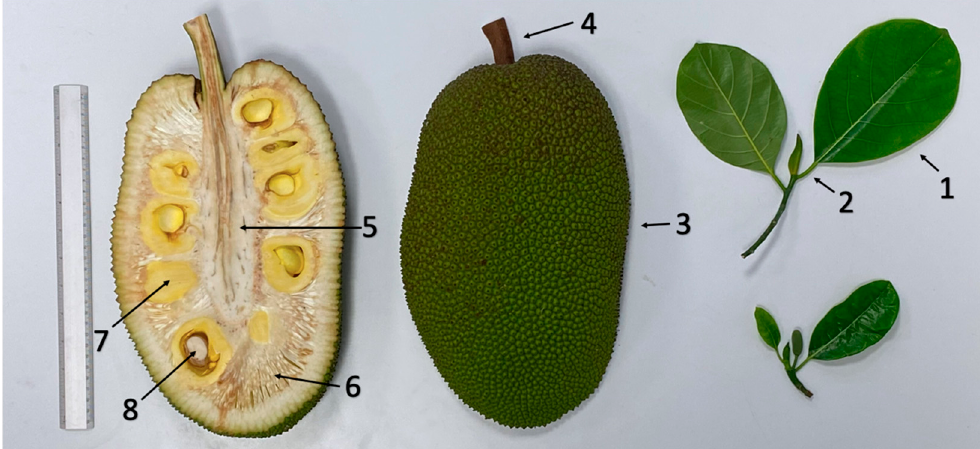
Figure 1. Morphological aspect of jackfruit at physiological maturity (1: leaves, 2: petiole, 3: peel, 4: peduncle, 5: rachis, 6: perianths, 7: bulb and 8: